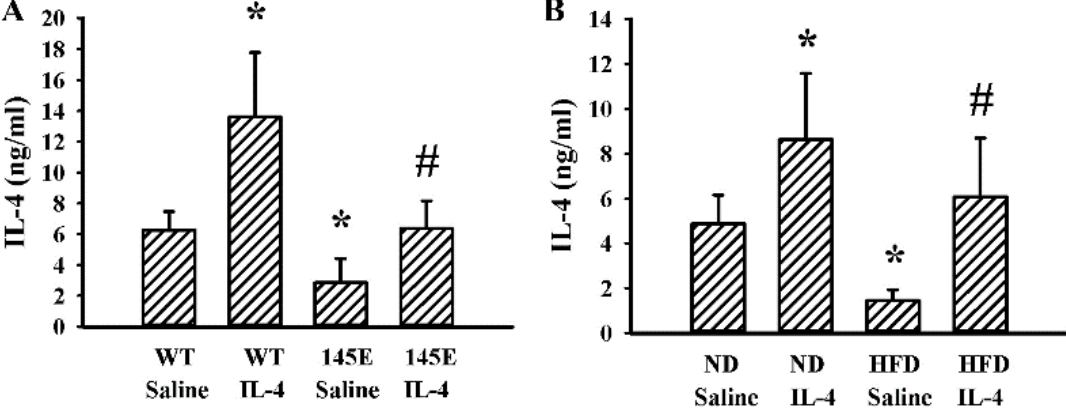
Figure 1. Obese mice showed reduced IL‐4 expressions. ( A ) Wild‐type C57BL/6 (WT) and leptin‐deficient 145E mice were fed the normal diet (ND) for 8 weeks. Simultaneously, normal saline and IL‐4 (1 μg/mouse) were intraperitoneally administrated twice a week. Blood samples were collected and subjected to ELISA for measuring IL‐4 levels. * p < 0.05 vs. WT/saline group and # p < 0.05 vs. 145E/saline group, n = 6. ( B ) C57BL/6 mice were fed with the normal diet (ND) or high‐fat diet (HFD) for 12 weeks. Simultaneously, normal saline and IL‐4 (1 μg/mouse) were intraperitoneally administrated twice a week for the last 8 weeks. Blood samples were collected and subjected to ELISA for the measurement of IL‐4 levels. * p < 0.05 vs. ND/saline group and # p < 0.05 vs. HFD/saline group, n = 6.